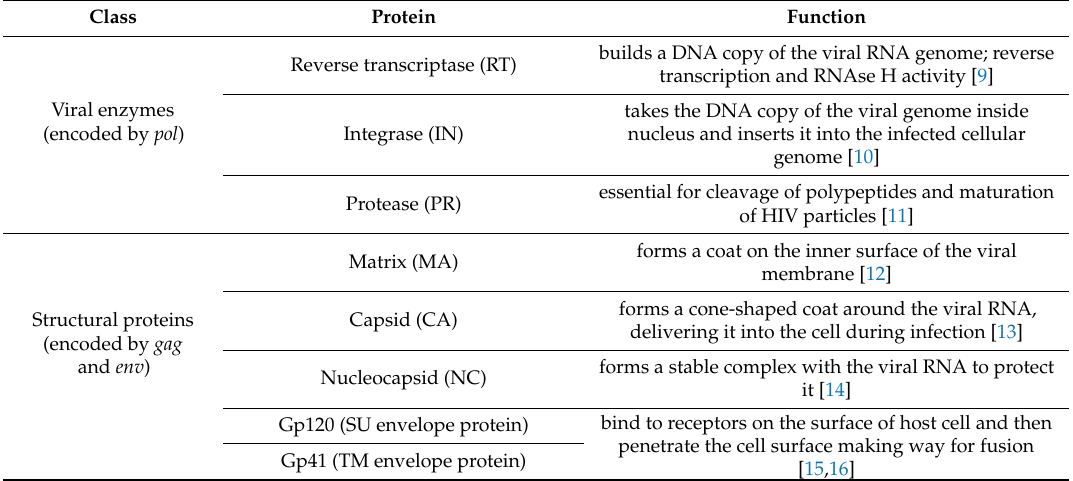
Table 1. HIV-encoded proteins and their